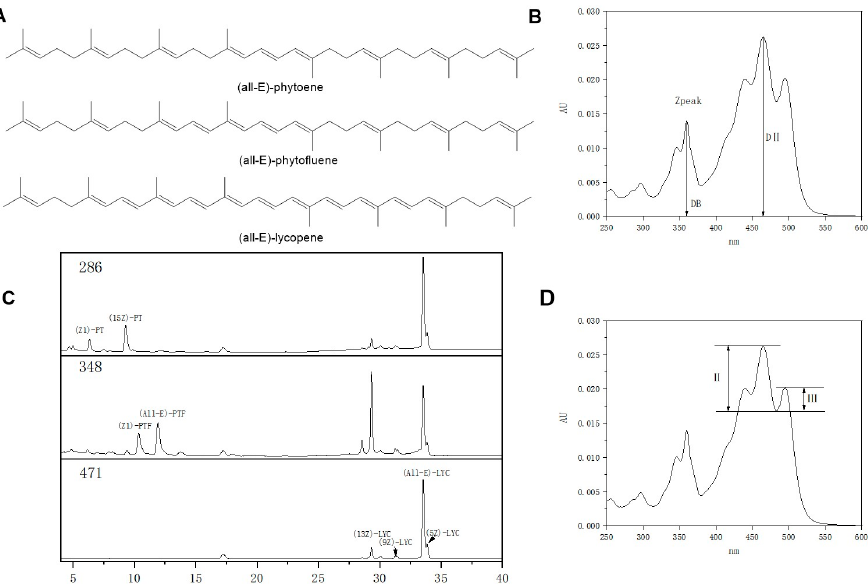
Figure 1. Structures of phytoene (PT), phytofluene (PTF) and lycopene (LYC), and isomer determi- nation methods. ( A ) Structures of PT, PTF and LYC. ( B ) The calculation method of Q value (DB/D ІІ ). ( C ) HPLC analysis of PT, PTF and LYC isomers. ( D ) The calculation method of % Ⅲ / Ⅱ .